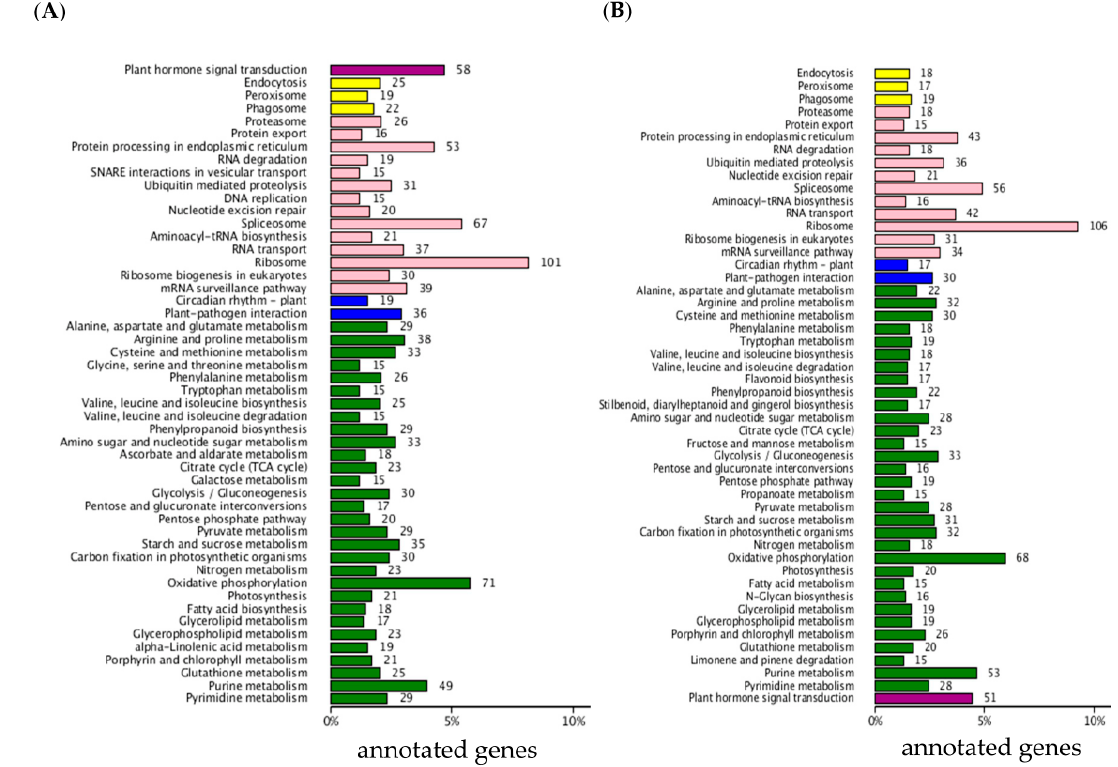
Figure 3. Pathway analysis of DEGs based on the KEGG database. ( A ) Analysis of DEGs at the bolting and ( B ) early flowering stages. The X -axis indicates the pathways, the Y -axis indicates the numbers of annotated genes.